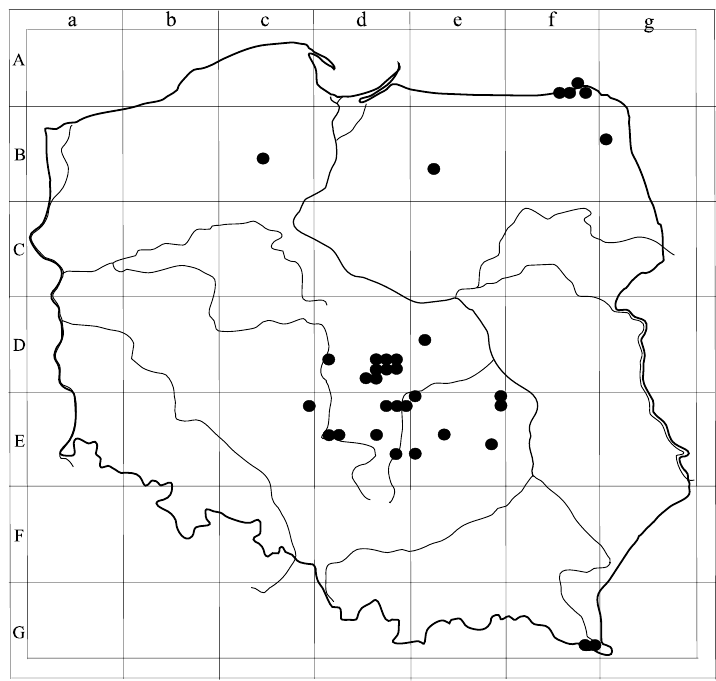
Fig. 1. Location of investigated sites on the atPoL grid square